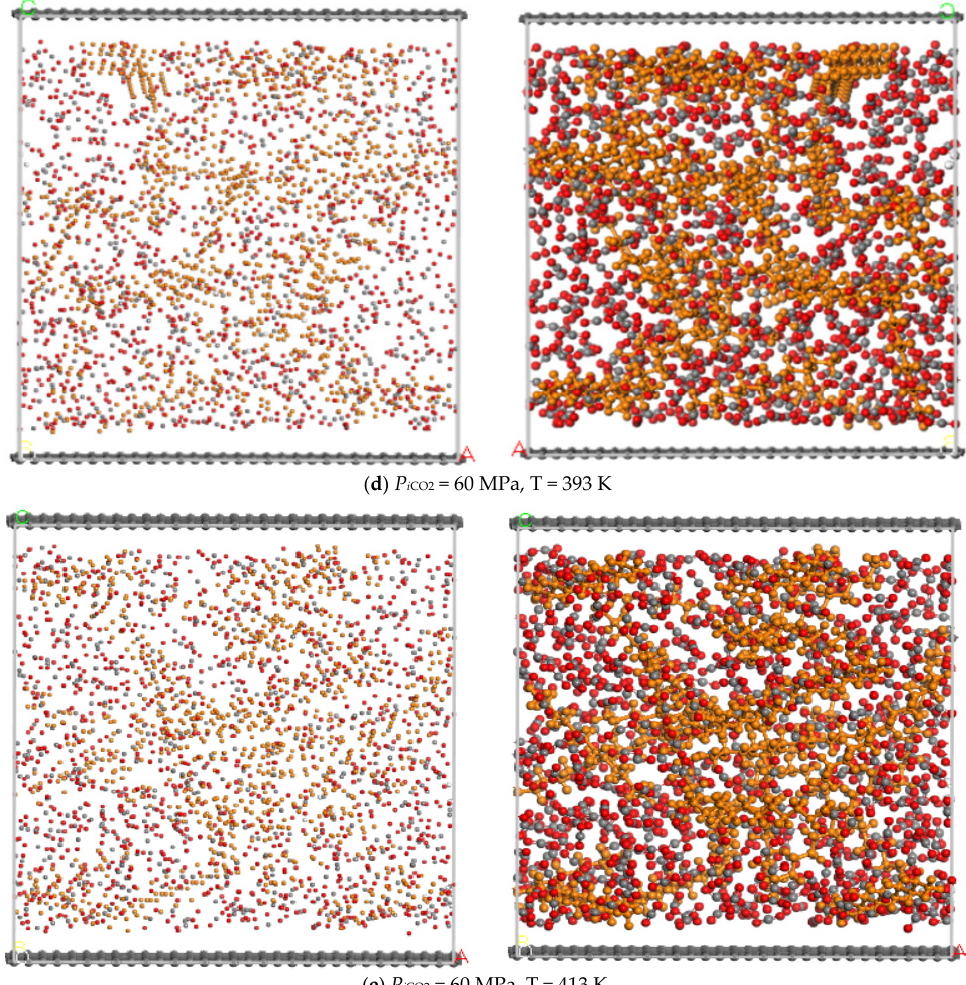
Figure 8. The schematic of instantaneous adsorption of molecules with CO 2 injection pressure of 60 MPa under different temperature. (A, B and C respectively represent different coordinate directions)